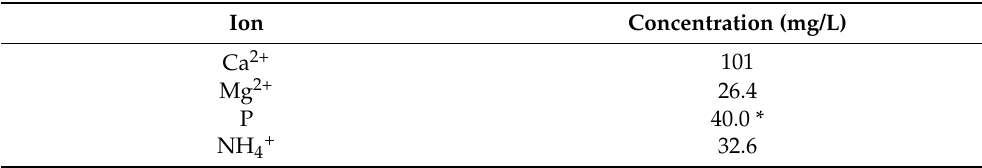
Table 1. Average observed ionic composition of real mixed